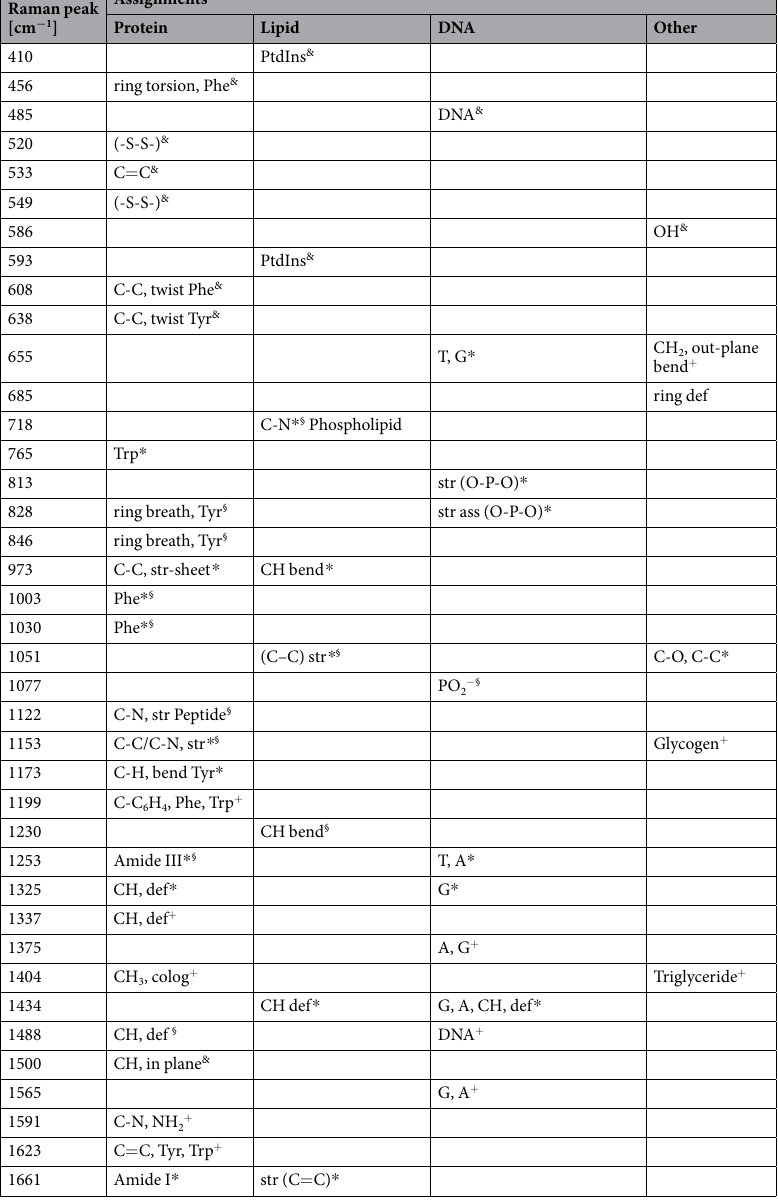
Table 1. SERS bands observed in the spectra recorded from the 4T1 breast cancer cells and the corresponding tentative assignments. Ref. 33 * ; 34 + ; 35 § ; 36 & (Phe: Phenylalanine; Tyr: Tyrosine, Trp: Tryptophan; PtdIns: